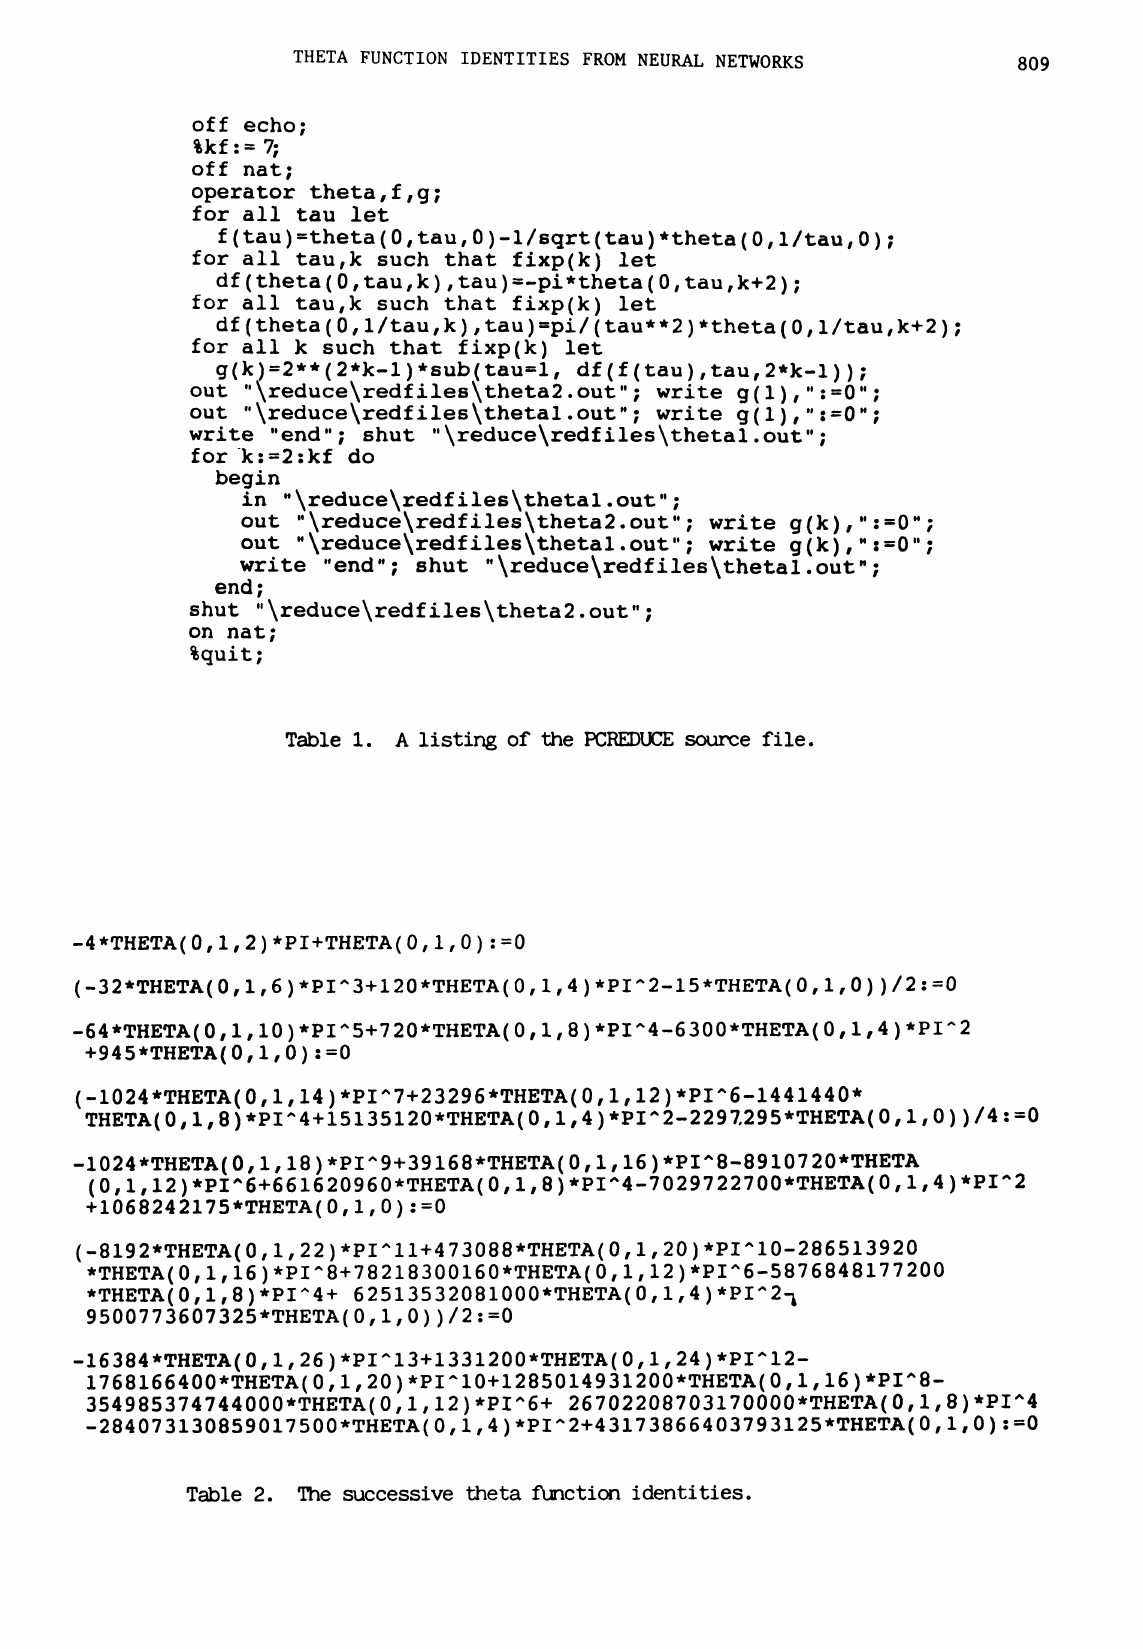
Table 2. The successive theta function